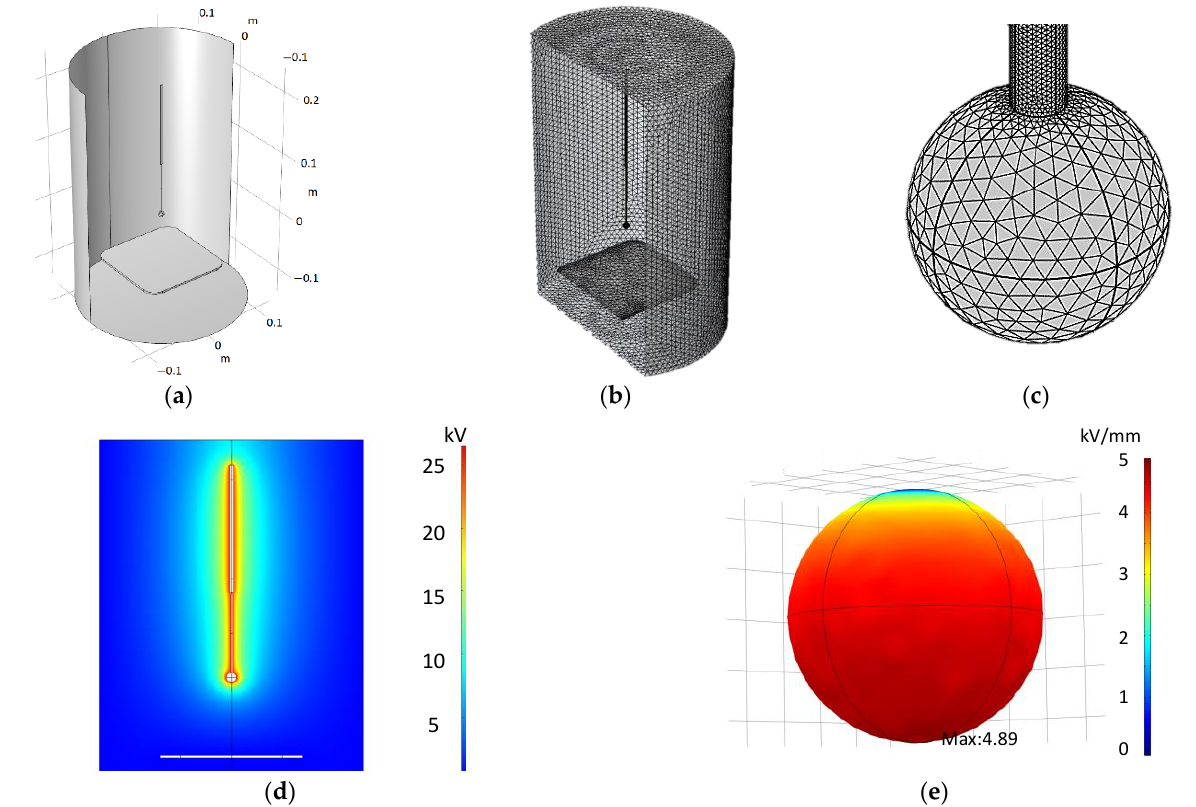
Figure 2. Simulation setup. ( a ) 3D geometry within the simulator. ( b ) Representation of the selected mesh. ( c ) Detail of the surface mesh on the sphere electrode. ( d ) Simulation of the electric potential around the electrode. ( e ) Simulation of the electric field on the sphere surface.